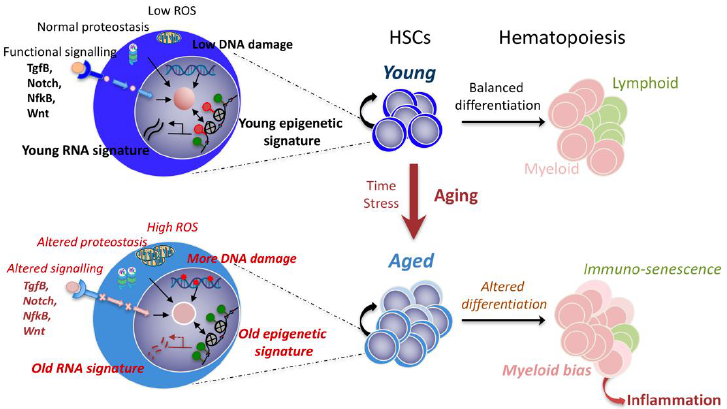
Figure 1. Cellular and molecular changes of aged HSCs. On the left, the zoom into young ( top ) and old ( bottom ) HSCs summarizes four biological processes that have been proposed to be involved in HSC aging: metabolism (ROS, proteostasis), DNA damage, epigenetics (green and red circles: active and repressive histone marks) and signaling. Interconnections between these processes lead to an altered function revealed by changes in transcriptome signatures. On the right, hematopoiesis is schematized. Young hematopoiesis is characterized by a balanced differentiation, leading to accurate levels of myeloid and lymphoid cells. With aging, intrinsic changes in HSCs occur, resulting in a myeloid bias and immunosenescence. All these changes probably play a role in age-related HSC deterioration, being inter-